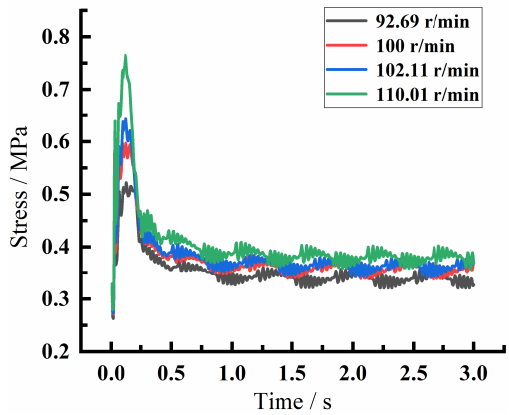
Figure 12. Variation of maximum blade stress at different rotation speeds.